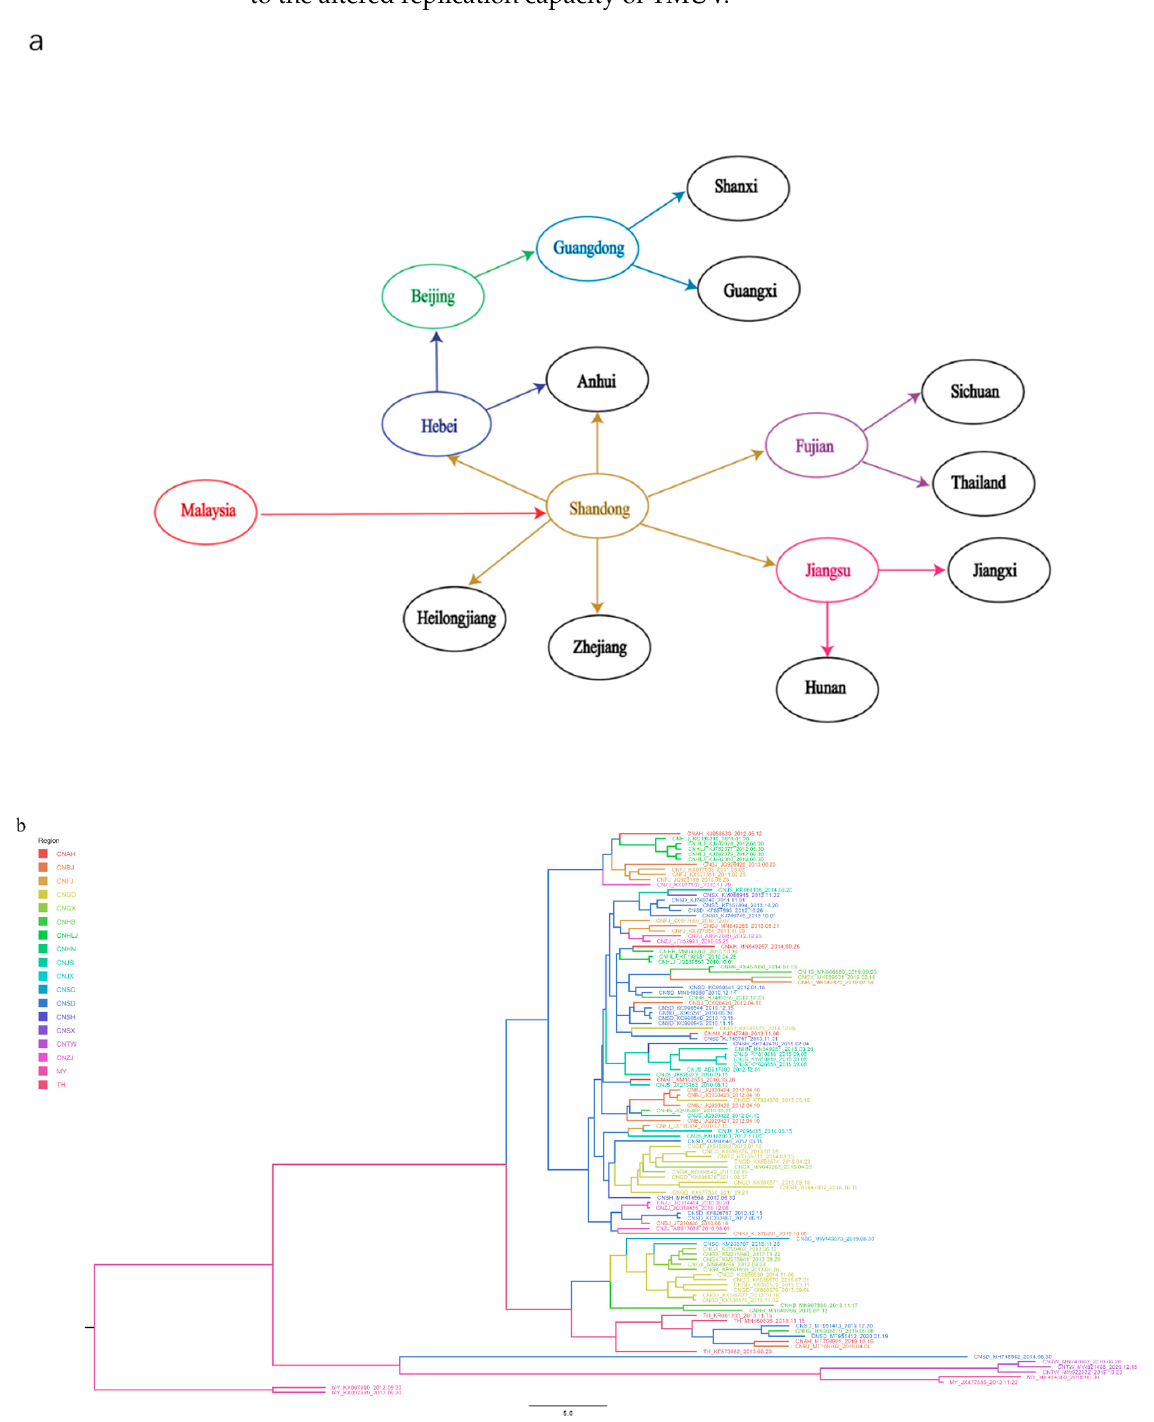
Figure 5. TMUV spread routines among different countries resolved using BSSVS. ( a ) The discrete phylogeographic analysis was performed with the Bayesian stochastic search variable selection (BSSVS) approach, for which we displayed the intensity of the transition rates associated with a BF > 15 and PP > 0.5. ( b ) Based on evolutionary analysis constructed from phylogeography, different regions are marked with different colors.